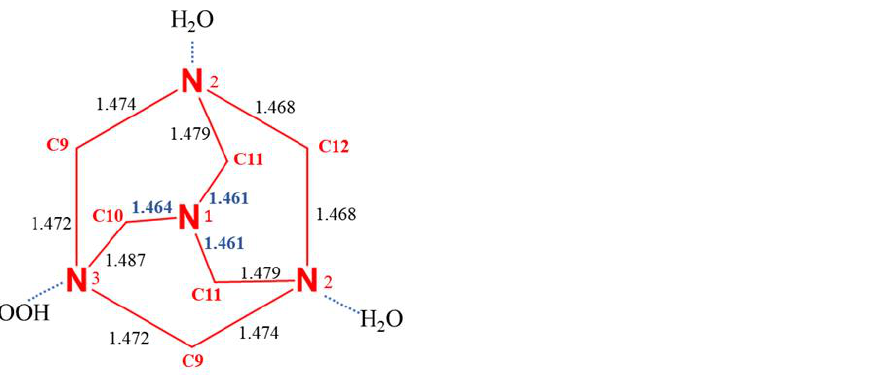
Figure 5. Schematic representation of the HTMA fragment in compound 1 , showing the bond distances in Angstrom.